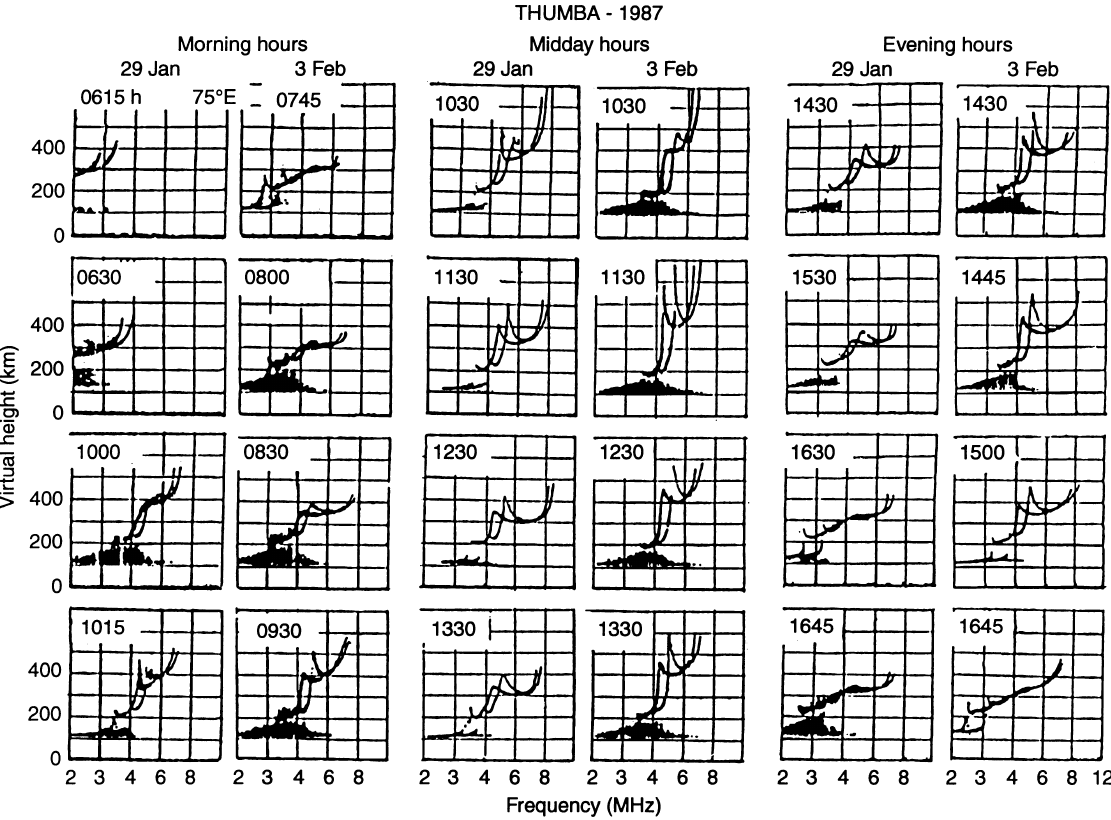
Fig. 9. Some selected ionograms at Thumba on 29 January and 3 February,